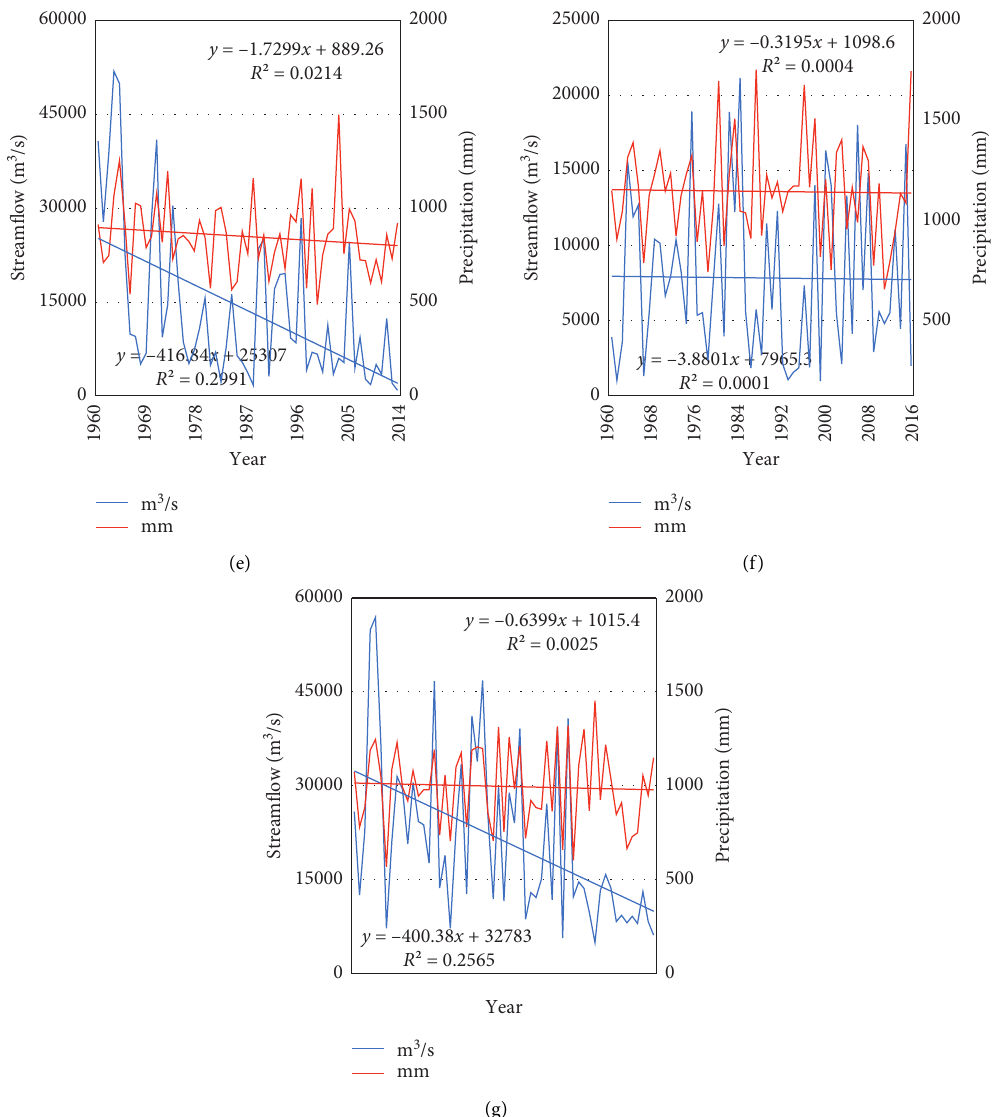
Figure 8: Long-term relation between precipitation and streamflow variation, in the course of 1960–2016. (a) Xiangcheng. (b) Zhumadian. (c) Gushi. (d) Fuyang. (e) Xinyang. (f) Xichong. (g) Average